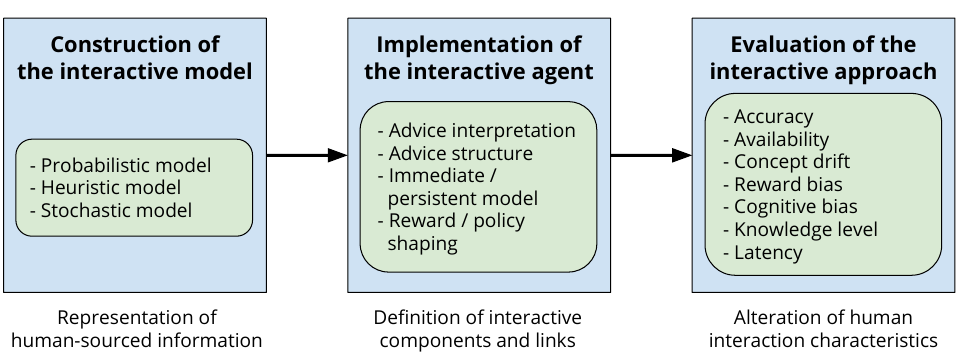
Figure 2. Simulated users methodology. While in the first phase, different representations of human- sourced information can be considered, the second phase considers the definition of processing components and communication links from the assisted reinforcement learning taxonomy. Finally, the third phase includes running experiments to test the approach by altering human interaction char-